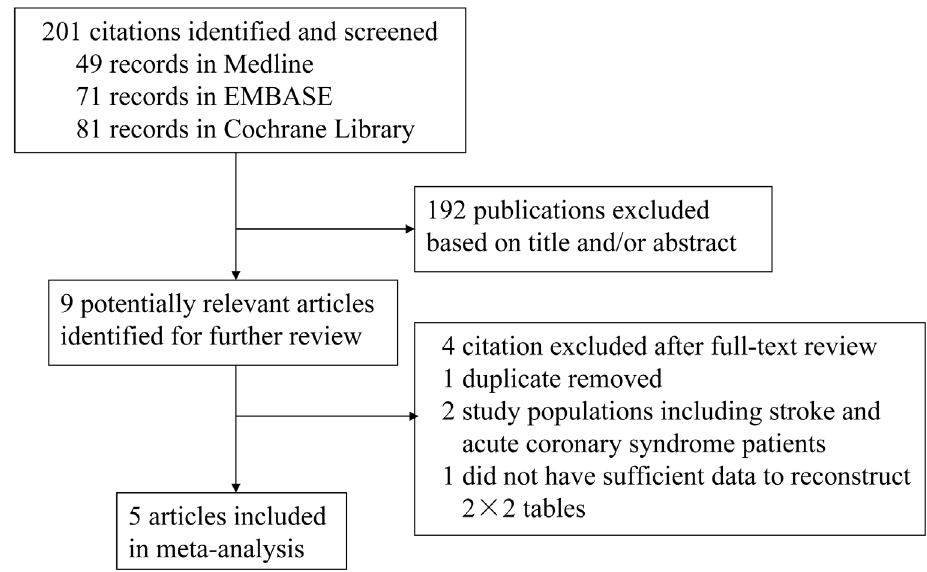
Fig 1. PRISMA flow chart of study identification and inclusion.